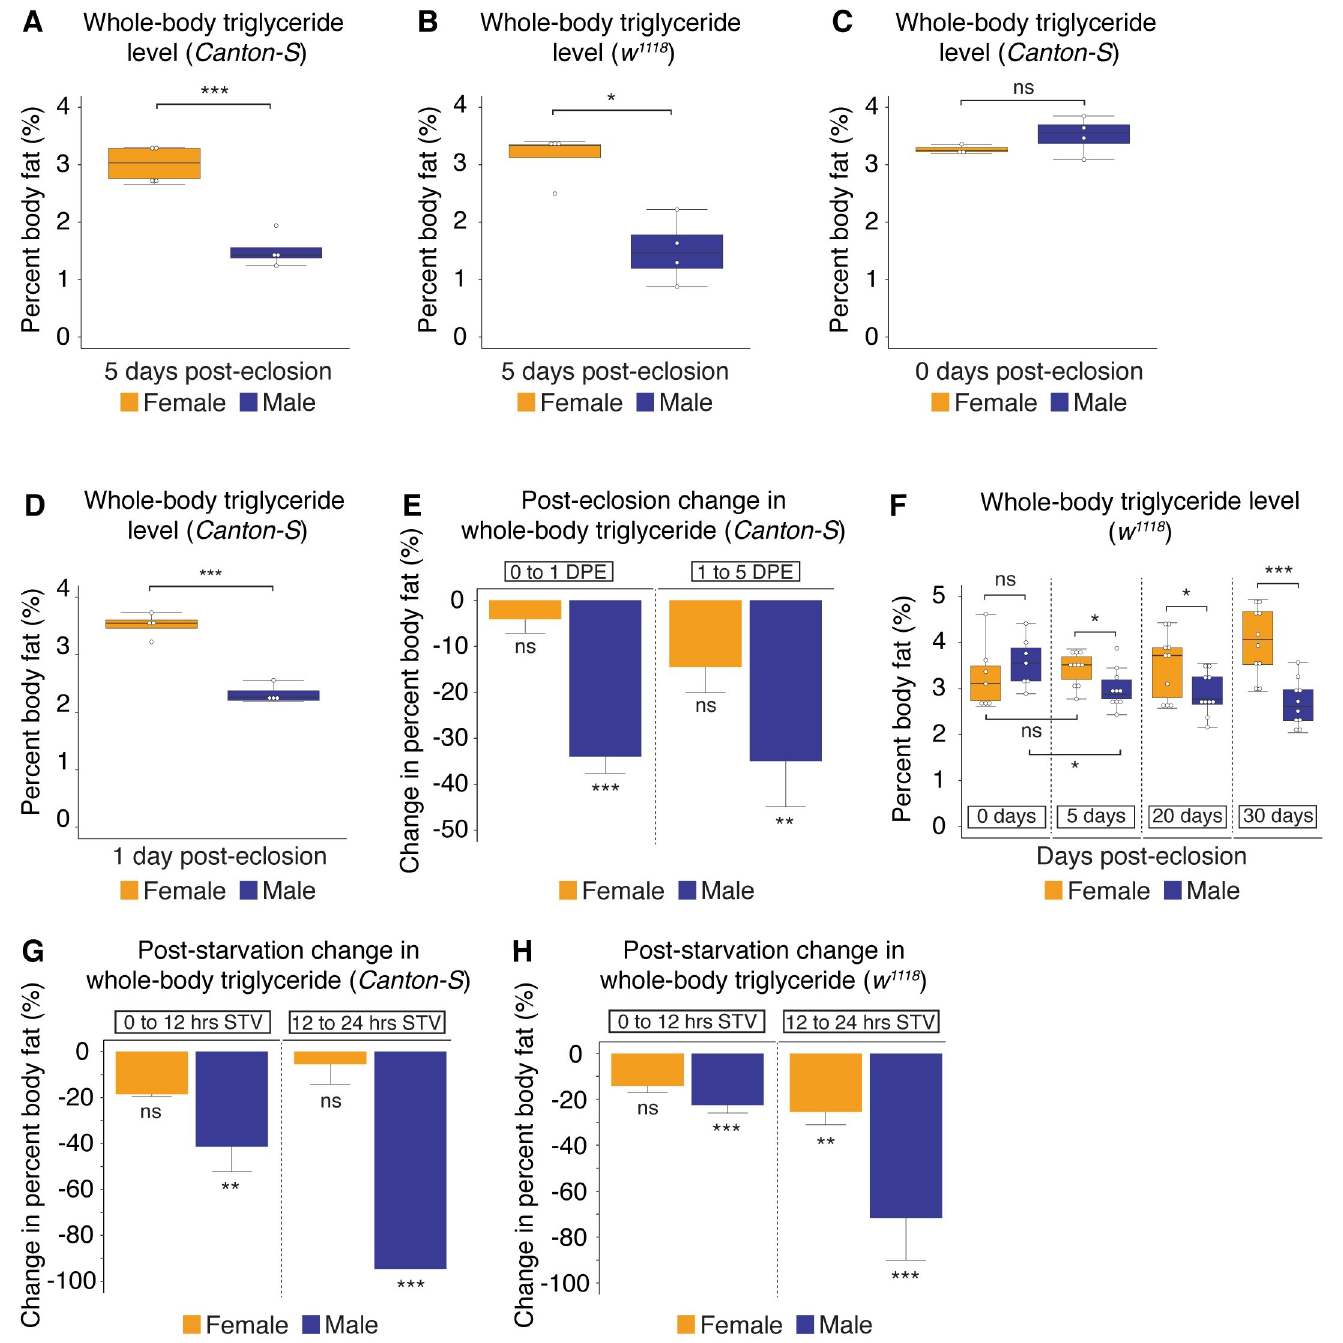
Fig 1. Sexual dimorphism in Drosophila triglyceride storage and breakdown. (A) Whole-body triglyceride storage in 5-day-old Canton-S virgin females was significantly higher than in age-matched Canton-S virgin male flies ( p = 5.4 × 10 − 4 ; Student t test). (B) Whole-body triglyceride storage in 5-day-old w 1118 virgin female flies was significantly higher than in age-matched w 1118 virgin male flies ( p = 2.3 × 10 − 2 ; Student t test). (C) No significant difference in whole-body triglyceride storage was found between newly eclosed virgin Canton-S females and age-matched virgin males ( p = 0.73; Student t test). (D) Whole-body triglyceride storage in 1-day-old Canton-S virgin females was significantly higher than in age-matched virgin males ( p = 1.2 × 10 − 4 ; Student t test). (E) In females, whole-body triglyceride levels were not significantly different between newly eclosed flies and flies collected at 1 DPE or between flies collected at 1 DPE and 5 DPE ( p = 0.91 and 0.38, respectively; one- way ANOVA followed by Tukey HSD test). In males, whole-body triglyceride storage was significantly lower at 1 DPE than in newly eclosed flies, with a further reduction in triglyceride storage between 1 DPE and 5 DPE ( p = 4.2 × 10 − 4 and 5.7 × 10 − 3 , respectively; one-way ANOVA followed by Tukey HSD test). (F) Whole- body triglyceride storage in w 1118 virgin females was not significantly higher than males at eclosion, but it was significantly higher by 5 DPE, a sex difference that was